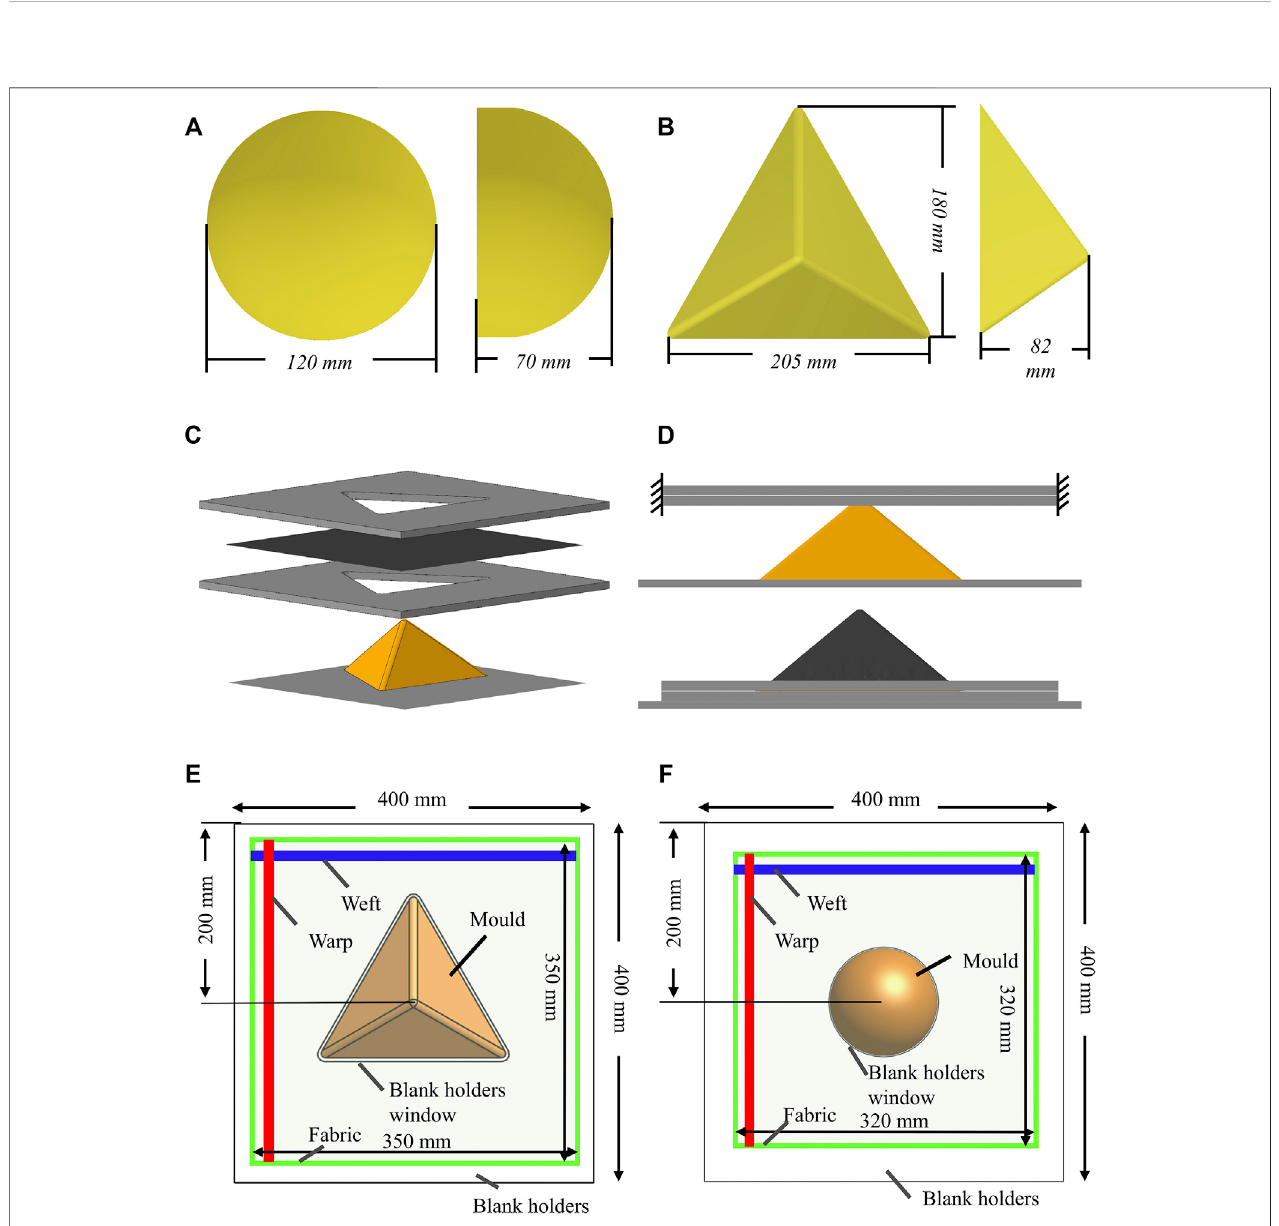
FIGURE 3 | Dimensions of (A) hemispheric and (B) tetrehedron mould; (C) Exlpoded view of punch forming setup; (D) Snap shots at the rspective postion of the differrentcomponentsofthesetupatthebegingingandtheendofthepunchformingprocess. (E) Generaldimensionsofthehemisphericpunch; (F) Generaldimensions of tetrahedral